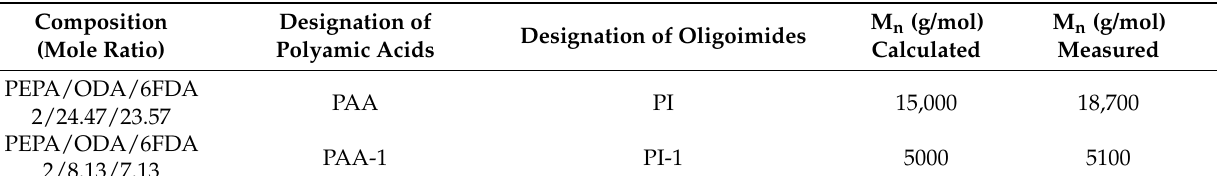
Table 1. Composition, M n , and designation of polyamic acids and oligoimides.